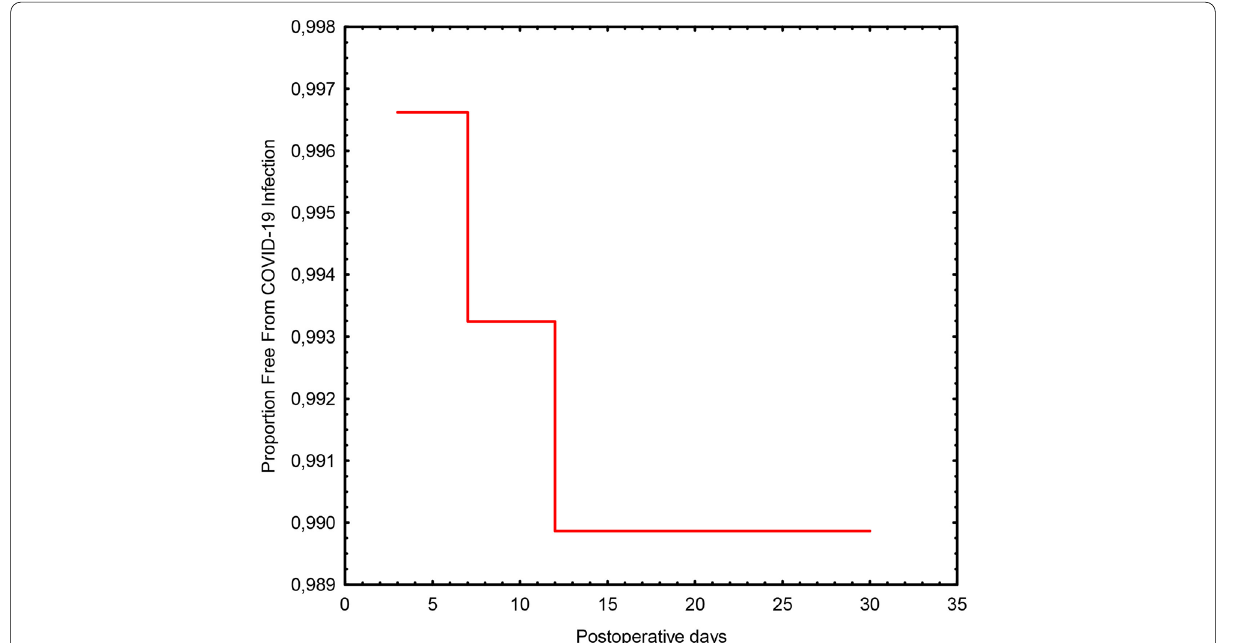
Fig. 2 Kaplan Meier curve depicting postoperative (30-day) risk of COVID-infection in group P patients. Patients at risk were 294 on first postoperative day and 292 at 30